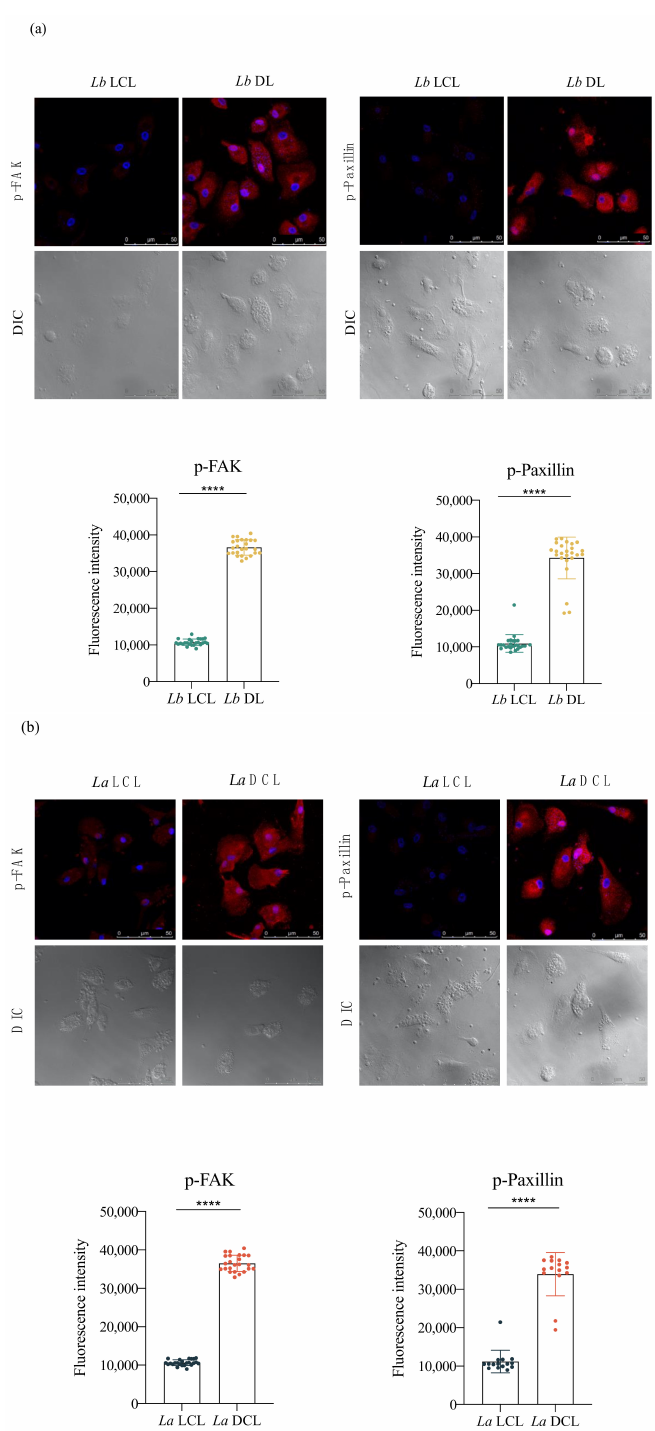
Figure 6. Lb DL and La DCL isolates induce hDC expression of adhesion complex proteins. Effects of Leishmania infection using isolates obtained from patients with localized or disseminated forms on phosphorylated FAK and paxillin protein levels. hDCs were infected with Lb LCL, Lb DL La LCL, or La DCL and stained with anti-pFAK and anti-p-Paxillin. Fluorescence intensity was quantified in 30 cells from each experimental group. ( a ) Fluorescence intensity of p-FAK and p-Paxillin in cells infected with Lb LCL or Lb DL. ( b ) Fluorescence intensity of p-FAK and p-Paxillin in cells infected with La LCL or La DCL. Red: anti-FAK or phosphorylated paxillin; blue, DAPI (cell nuclei); grayscale, DIC. **** p < 0.001 (Student’s t -test). Data are representative of three independent